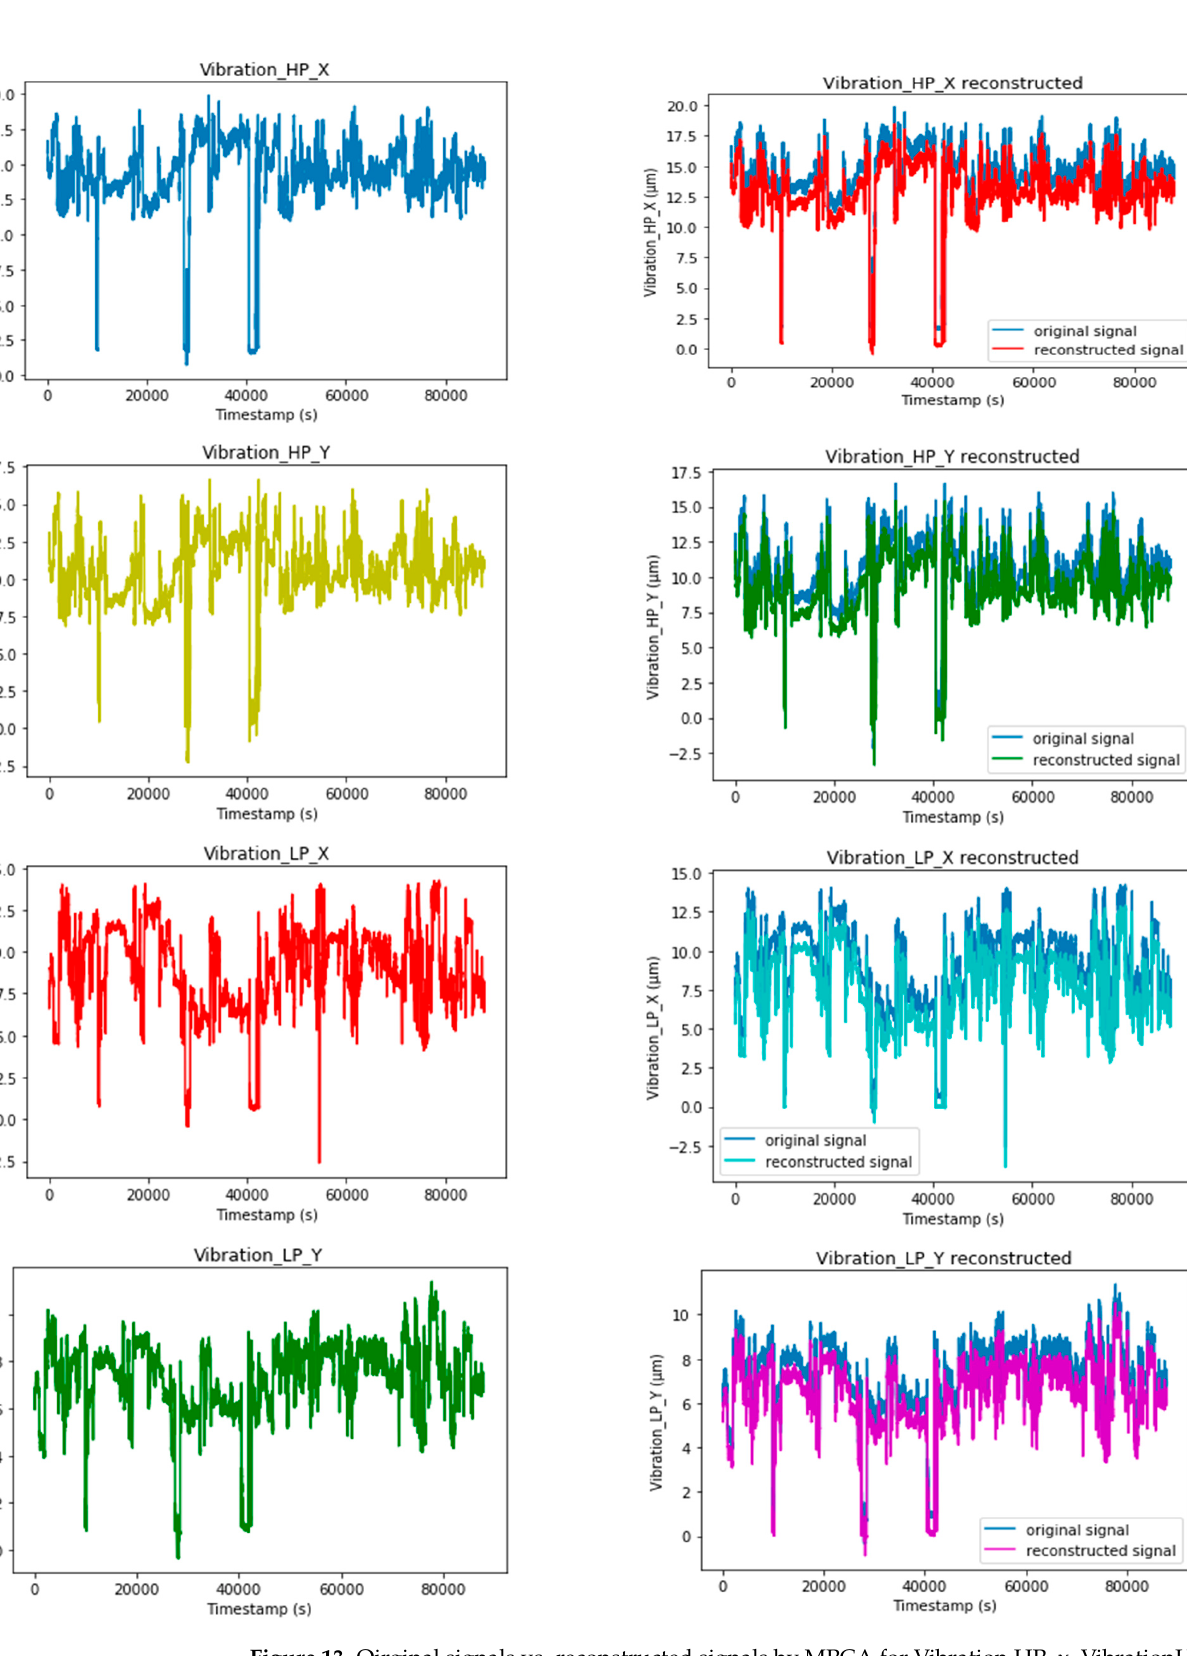
Figure 13. Oirginal signals vs. reconstructed signals by MPCA for Vibration HP_x, VibrationHP_y, VibrationLP_x, and and VibrationLP_y with a 0.3 threshold.